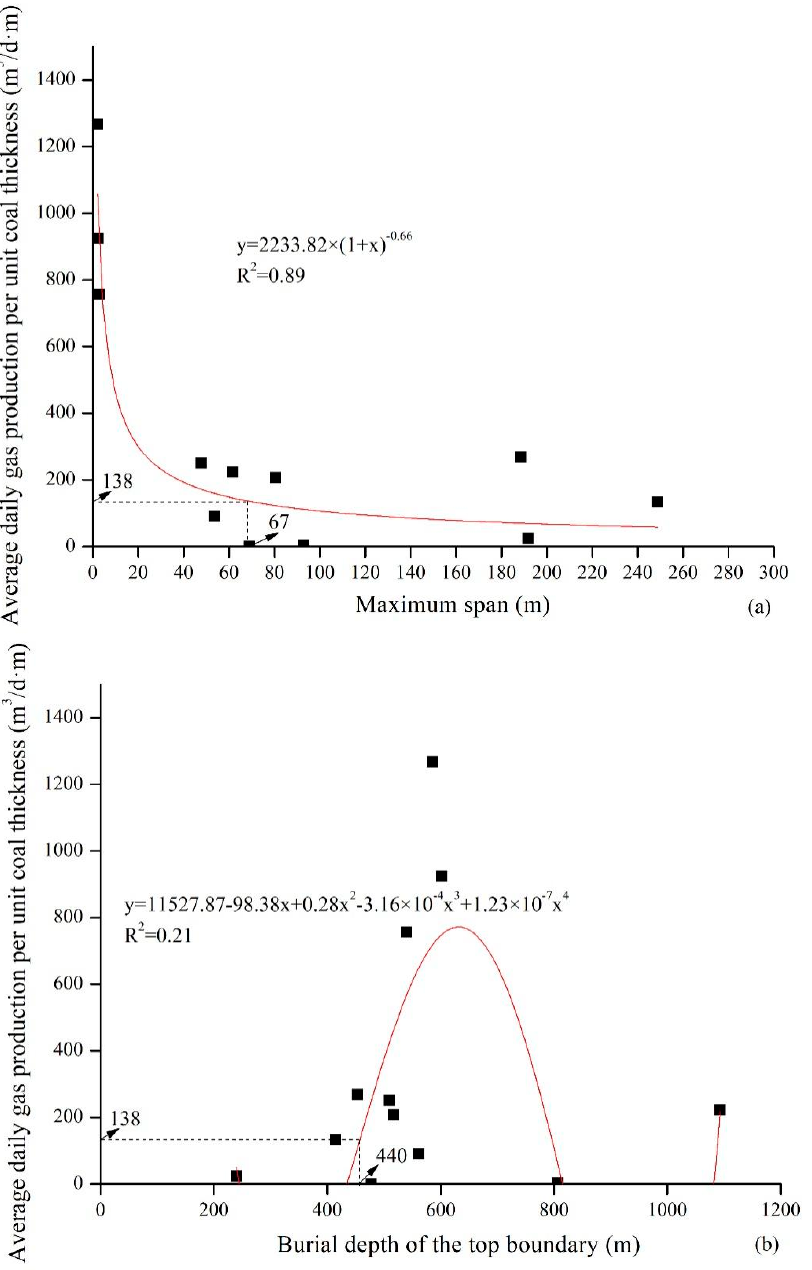
Figure 5. Relationships between the average daily gas production per unit coal thickness and the maximum span ( a ) and the burial depth of the top boundary of the production coal seam combination ( b